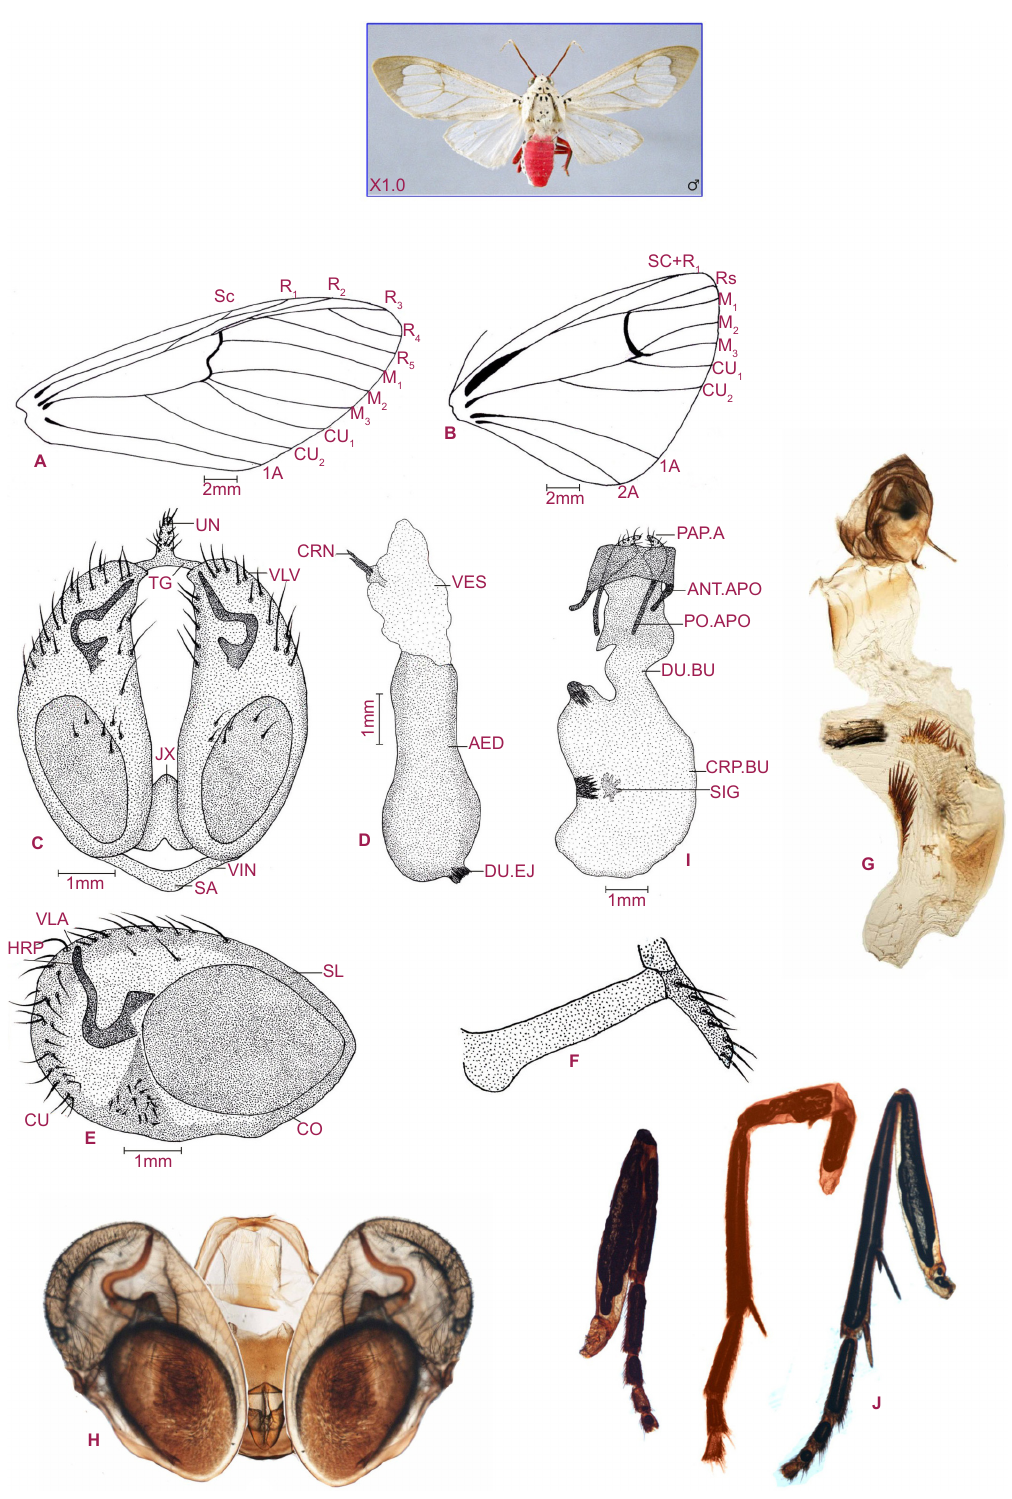
Image 1. Amerila eugenia (Fabricius). A - Forewing; B - Hindwing; C & H - Male genitalia; D - Aedeagus; E - Valva (right); F - Uncus with Tegumen (lateral view); G & I - Female genitalia; J- from left to right: fore leg, mid leg & hind